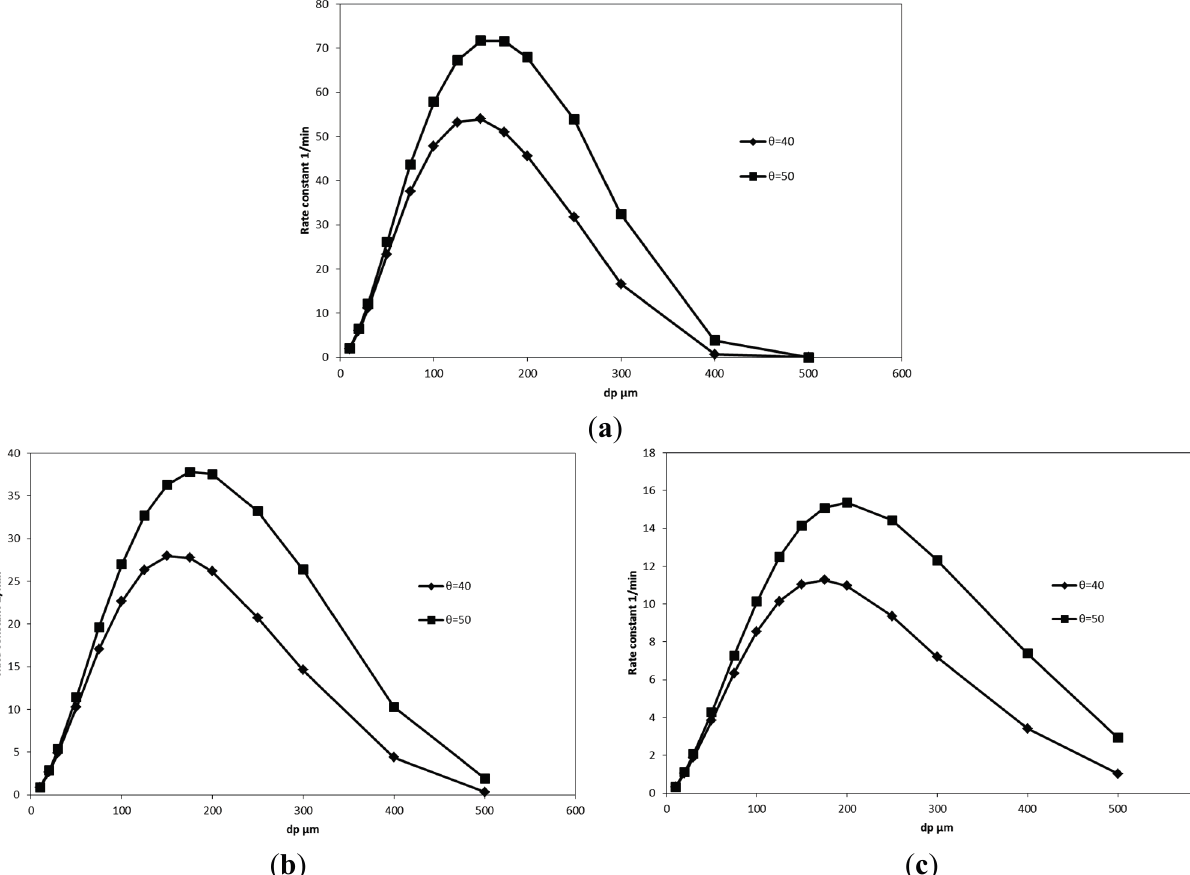
Figure 13. ( a ) Average rate constant for 0.5 mm bubble diameter and for single particle sizes; ( b ) average rate constant for 0.7 mm bubble diameter and for single particle sizes; ( c ) average rate constant for 1.0 mm bubble diameter and for single particle sizes.